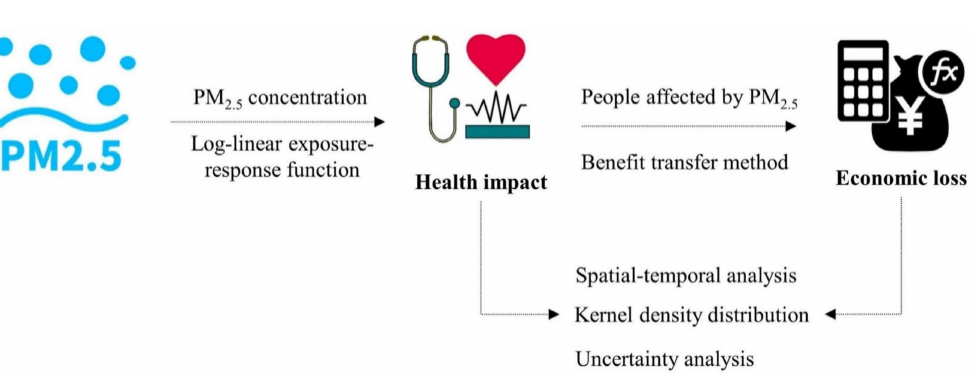
Figure 1. The research